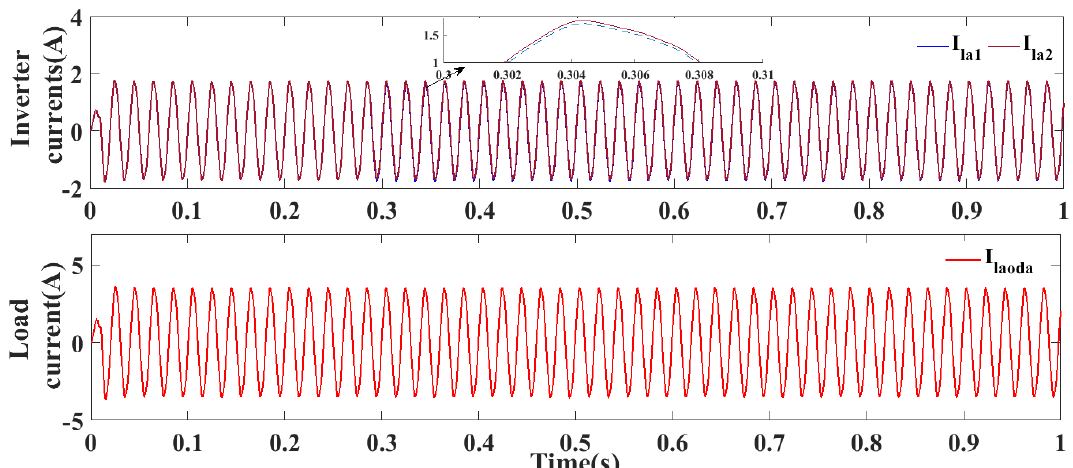
Figure 10. Current sharing with proposed reinforced droop control.